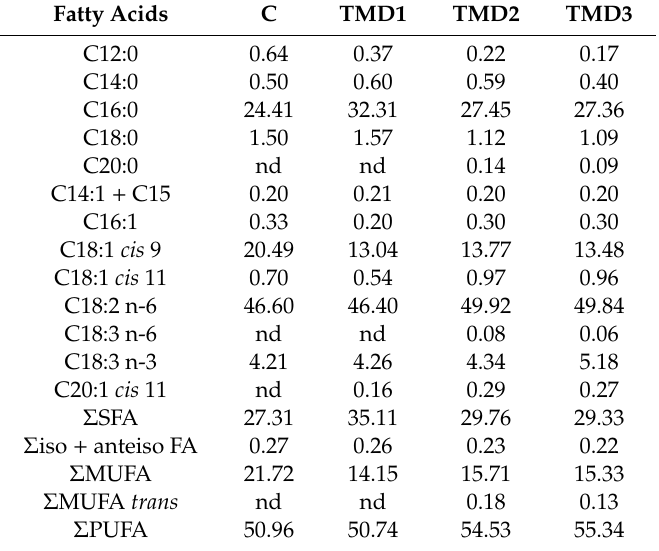
Table 3. Fatty acid (FA) profile (g / 100 g of TDFA) of the control (C) and experimental (TMD1–TMD3) diets. Fatty Acids C